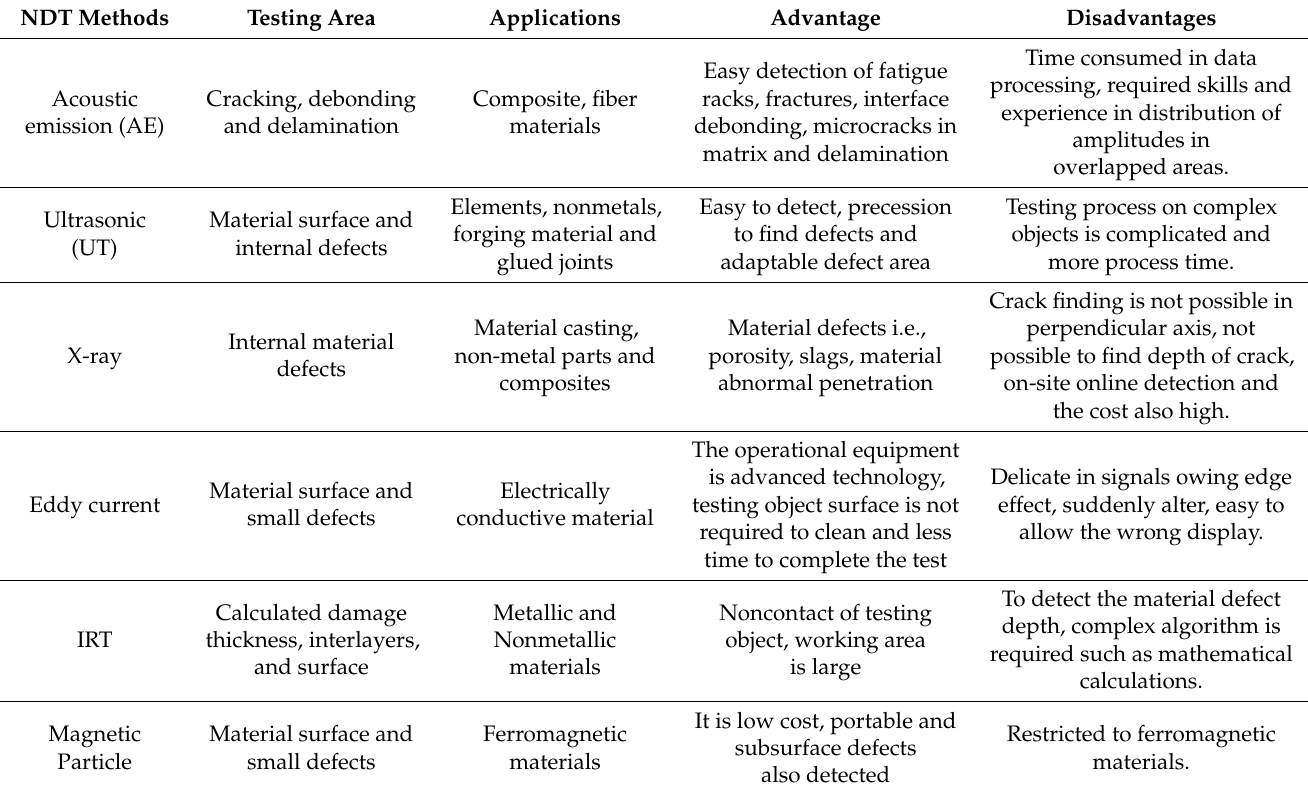
Table 1. Review survey on NDT testing methods with their